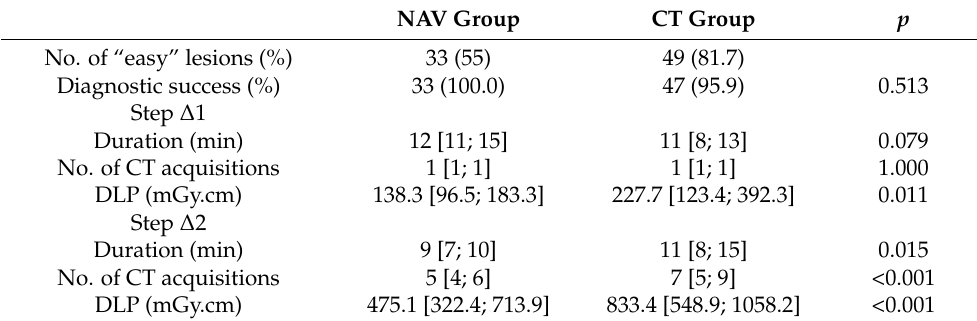
Table 3. Outcomes for “easy” lesions in terms of diagnostic success, procedure duration, number of CT acquisitions and radiation dose.